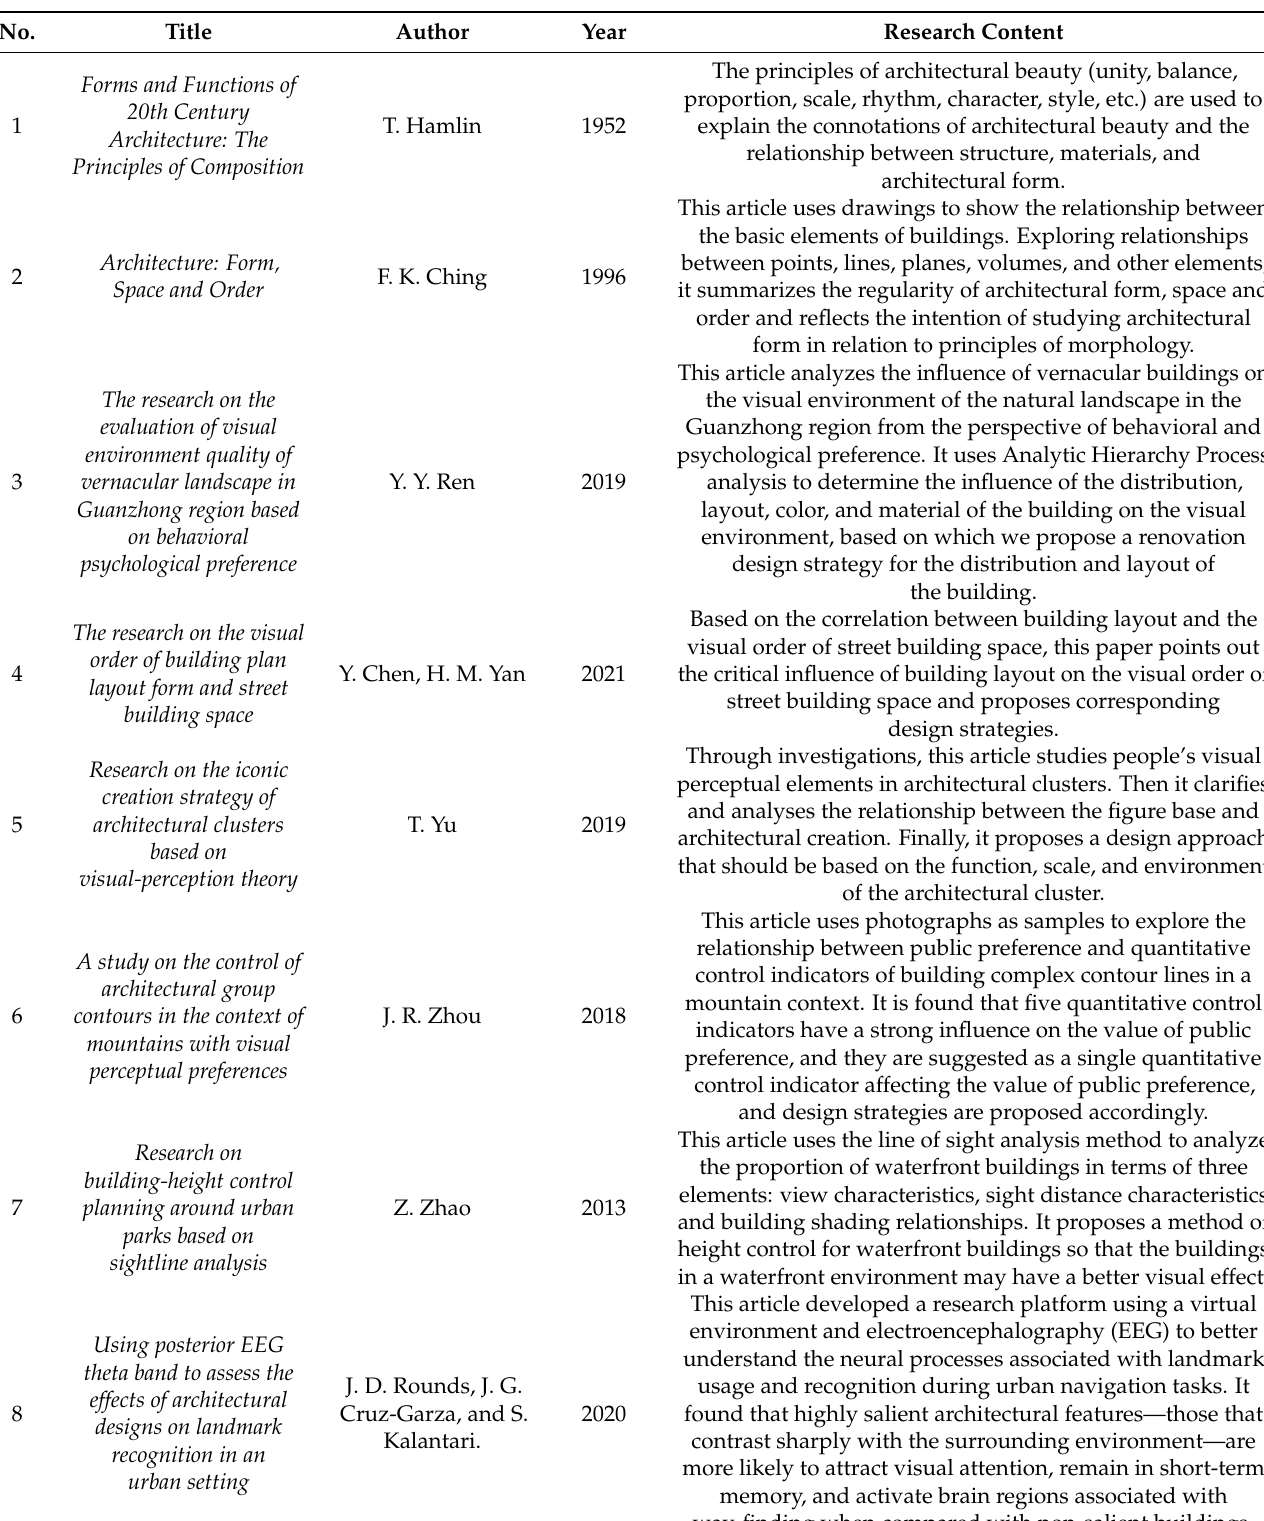
Table 2. Literature review of factors influencing the visual representation of building in the natural